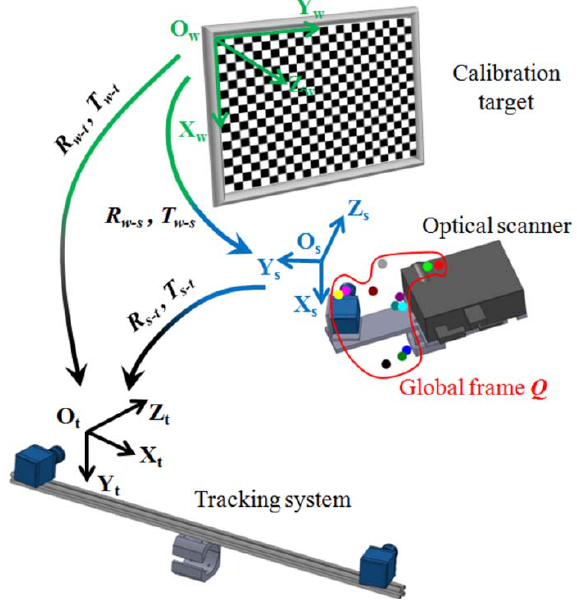
Figure 4. Scheme of the global markers frame calibration relating 3D markers coordinates in the optical scanner reference system. Different colors identify different